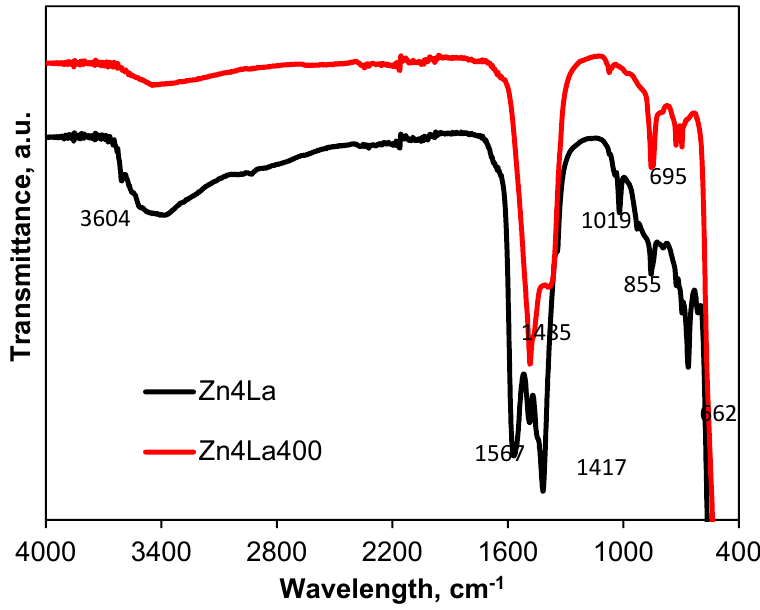
Figure 7. Infra-red (IR) spectra of the samples .